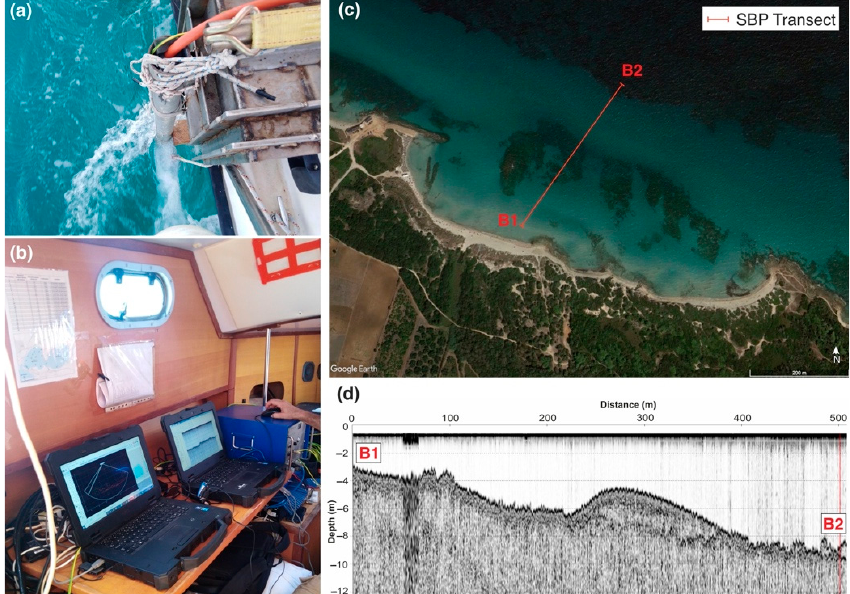
Figure 11. SBP field survey and data processing. ( a ) SBP transducer during the data acquisition; ( b ) hardware system and laptops for data monitoring; ( c ) map showing the navigation path; ( d ) 2-dimensional stratigraphic cross sections data processing.